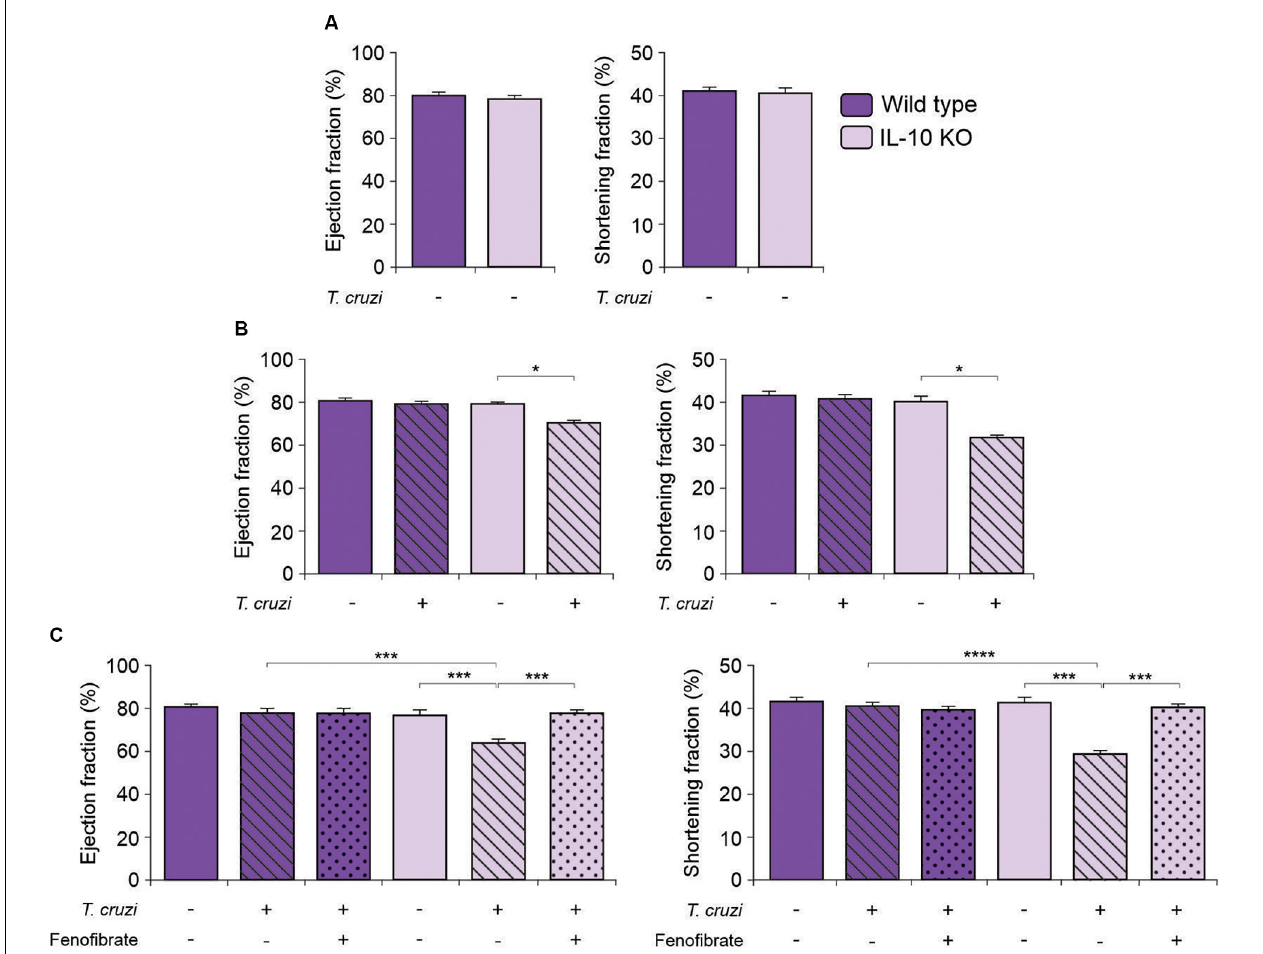
FIGURE 3 | Echocardiographic studies in IL-10 KO and WT mice. The Ejection fraction and the Shortening fraction were measured by echocardiography in uninfected, T. cruzi- infected, and T. cruzi- infected fenofibrate-treated IL-10 KO and WT mice. (A) Ejection fraction and Shortening fraction measured before infection in IL-10 KO and WT mice. (B) Ejection fraction and Shortening fraction measured, at week 5, in uninfected and T. cruzi- infected IL-10 KO and WT mice. (C) Ejection fraction and Shortening fraction measured, at week 9 in uninfected, T. cruzi- infected and T. cruzi- infected and fenofibrate-treated (treatment finished) IL-10 KO and WT mice. Differences between groups were analyzed by Student t test (mean ± SEM) and ANOVA (mean ± SEM) followed by Tukey post hoc test. 7 mice per group, 3 replicate experiments. * p < 0.05; *** p < 0.001; and **** p < 0.0001.